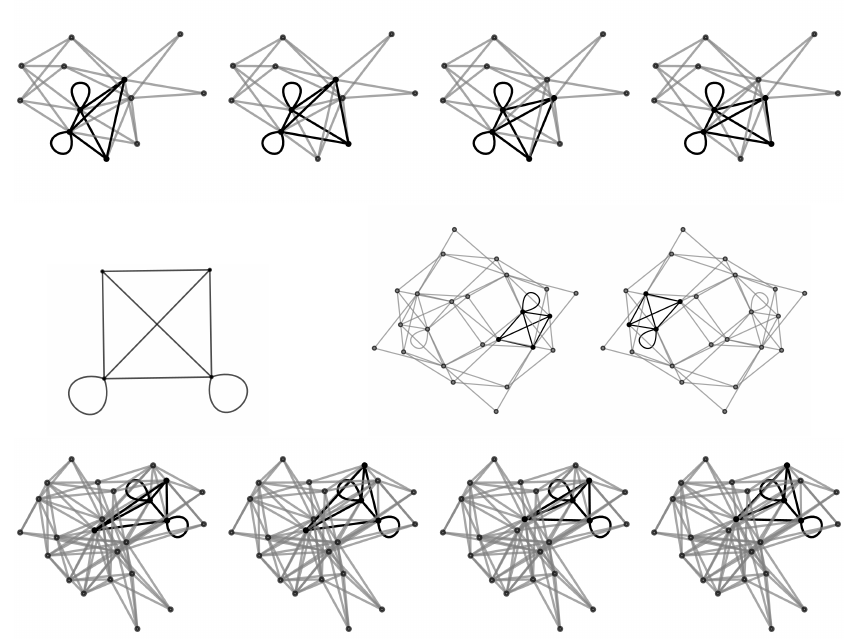
Figure 22. Maximum cliques for: A 30 ( top row ); A 60 ( middle row ); and A 90 ( bottom row ). The left panel in the middle row shows the complete graph isomorphic to the maximal cliques in this set of graphs. Note that the isomorphism is up to the